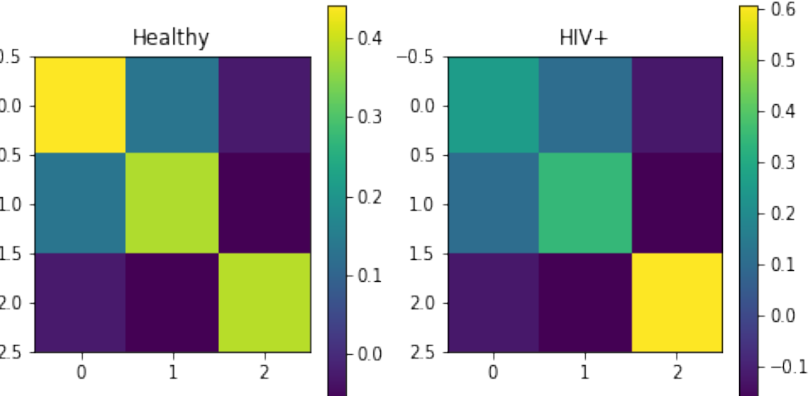
Figure 5. Estimated diffusion tensors g 1 ( z 1 ) , g 2 ( z 1 ) at first arc length from the healthy group and the HIV+ group are shown as 3 ∗ 3 matrix. The horizontal and vertical axis denotes the rows and columns of the matrix. Entry values inside the matrix are represented in different colors. Based on the color bar, differences between healthy and HIV+ groups could be observed, especially on the diagonal